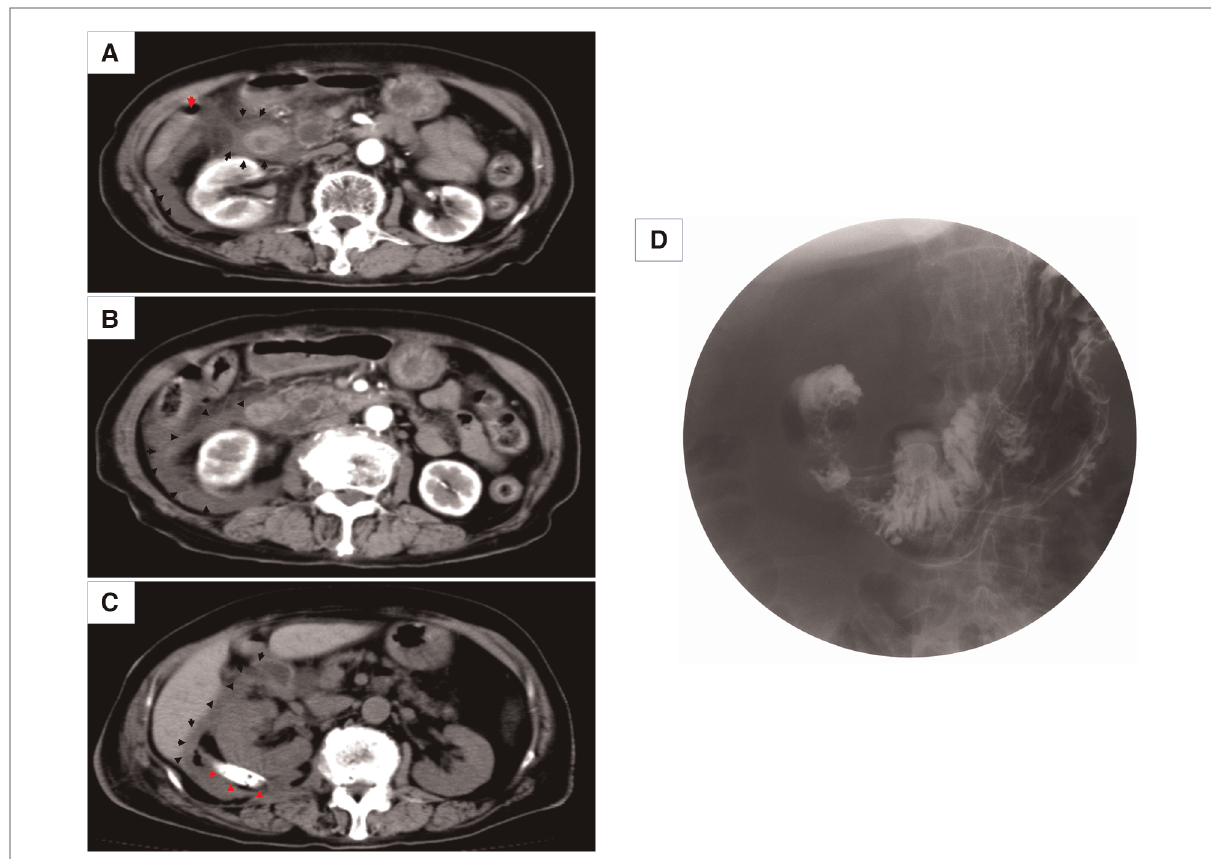
FIGURE 2 ( A,B ) Enhanced CT scans of the patient on admission and 7 days after conservative treatment (red arrows point to free abdominal gas, black arrows point to peri-duodenal and retroperitoneal exudate). ( C ) CT scan 7 days after percutaneous retroperitoneal tube placement for drainage (red arrows point to the placed retroperitoneal double cannula, black arrows point to periduodenal and retroperitoneal exudate). ( D ) shows a gastrointestinal barium study of the patient.